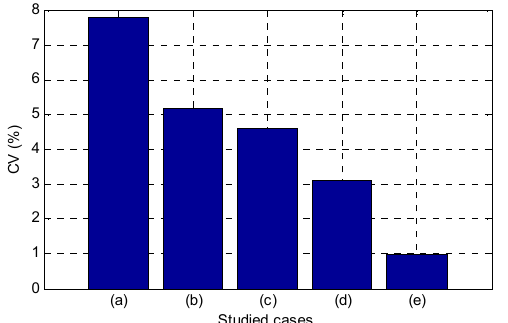
Figure 8. Coefficient of variation ( CV ) of the root-mean-square error obtained for five different models: ( a ) uncorrected signal; ( b ) corrected signal without ambient temperature and humidity; ( c ) corrected signal without ambient humidity; ( d ) corrected signal without ambient temperature; and ( e ) corrected signal.